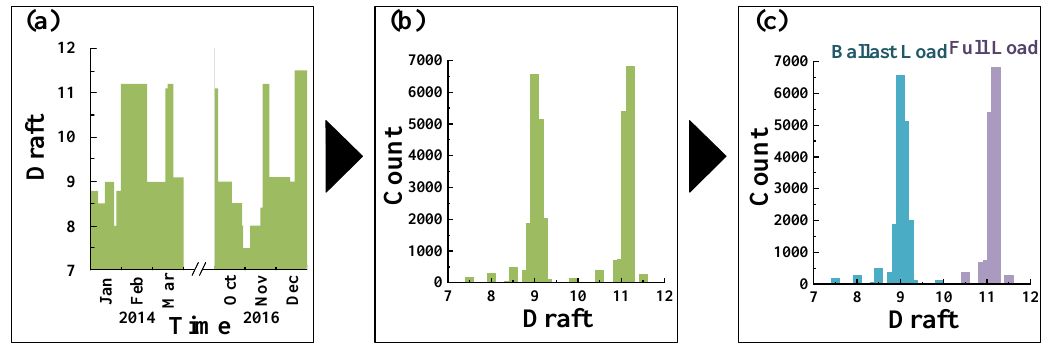
Figure 4. The extraction of ship point pairs. (a) Original ship trajectories; (b) The process of extracting the ship point pairs; (c) The process of eliminating abnormal ship point pairs; (d) The extracting result of ship point pairs. The adjacent points in some ship point pairs have significant time differences, which cannot be considered to be the same voyage. Therefore, we set the threshold as 24 h to remove these anomalies [5]. If the time difference between the adjacent points is more than 24 h, the ship point pair will be deleted; otherwise, it will be retained (see Figure 4c). The retained ship point pairs will be used for the subsequent oil flow statistics (see Figure 4d). 3.3. Discrimination of the Oil Tanker Load Condition by the K-Means Clustering Method The load condition of the oil tanker while passing through the MOC needs to be determined to develop the statistics for the oil flow. Park et al. mentioned that for the tanker and bulk carriers, the two most common operating conditions are the full load and ballast conditions [46]. Therefore, we only considered the full load and the ballast load of the tanker in the calculations, regardless of the other conditions. For every oil tanker, we counted the record number under the different drafts and obtained the statistical results. The frequency histogram would be drawn by taking the draft as the abscissa and the record number as the ordinate (see Figure 5b). The frequency distribution map of the oil tanker draft presents a bimodal distribution structure, and the two peaks correspond to the ballast load and full load, respectively. This fact enables us to discriminate the load condition of every oil tanker using the k-means clustering method [47,48]. The k-means clustering method is conducted by taking the draft as the clustering distance and the record number as the weight. The category with a small value of